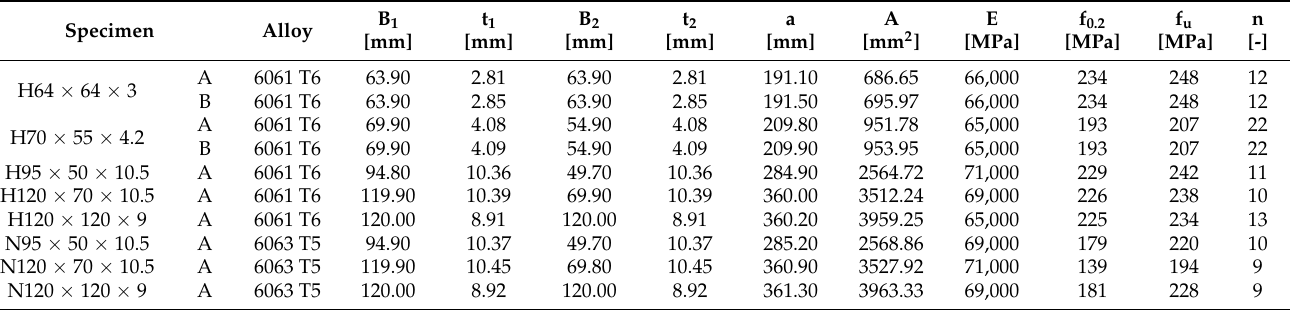
Figure A1. Geometric scheme of box section. Table A1. Experimental properties of stub column tests.